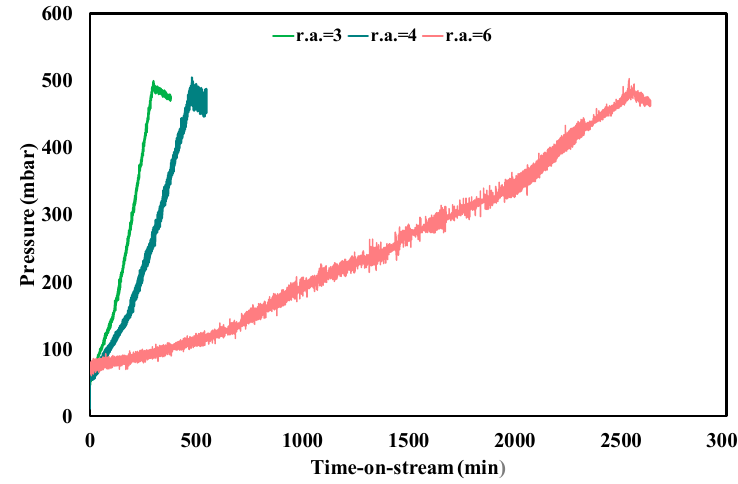
Figure 4. Pressure drops profile through the catalytic bed during stability tests and gasification measurements at 450 ◦ C, f.r. between 3 and 6, WHSV = 4.1 h − 1 .